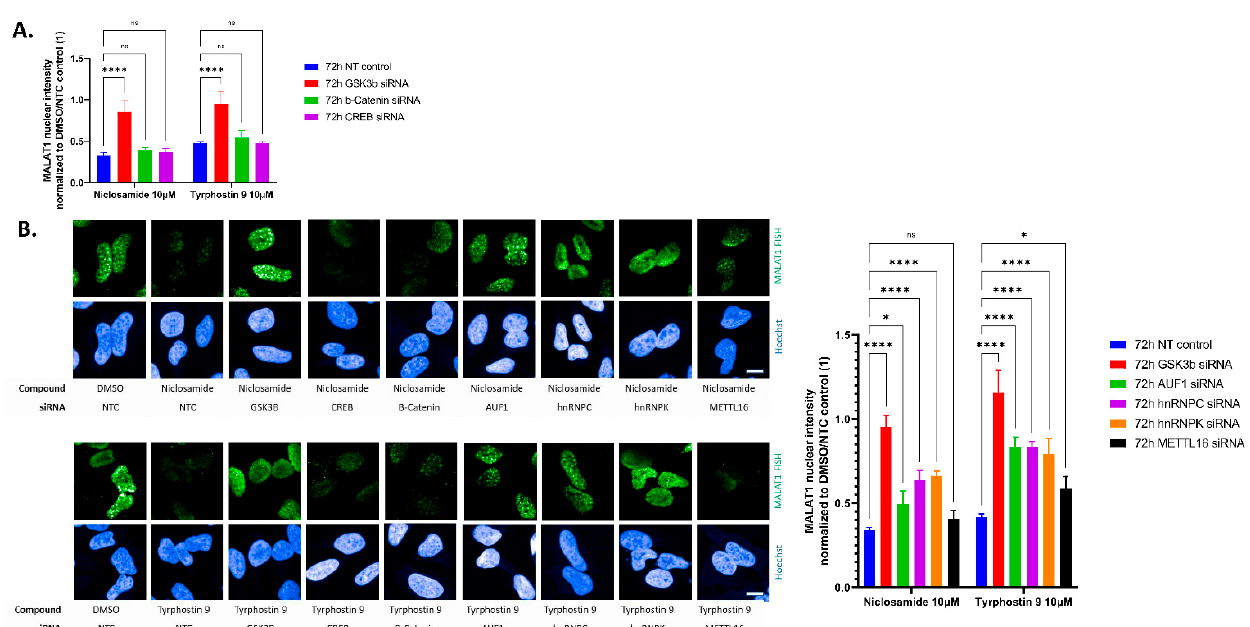
Figure 6. ( A ): Quantification of nuclear MALAT1 staining after siRNA and compound treatment. GSK3B but not b-Catenin or CREB knockdown significantly prevents compound induced reduction of nuclear MALAT1 staining intensity. Bars show mean with SD. ( B ): Hela stained for MALAT1 lncRNA by fluorescence in-situ hybridization after 72 h siRNA against the indicated target followed by 2 h treatment with DMSO control or HTS hits at 10 µ M. Nuclei are stained by Hoechst. Scale bar ~10 µ m. Quantification of nuclear MALAT1 staining after siRNA and compound treatment. GSK3B as well as to a lower extent hnRNPC and hnRNPK knockdown significantly prevent compound induced reduction of nuclear MALAT1 staining intensity. Bars show mean with SD. **** p value < 0.0001; * p value < 0.1; NS = not significant.